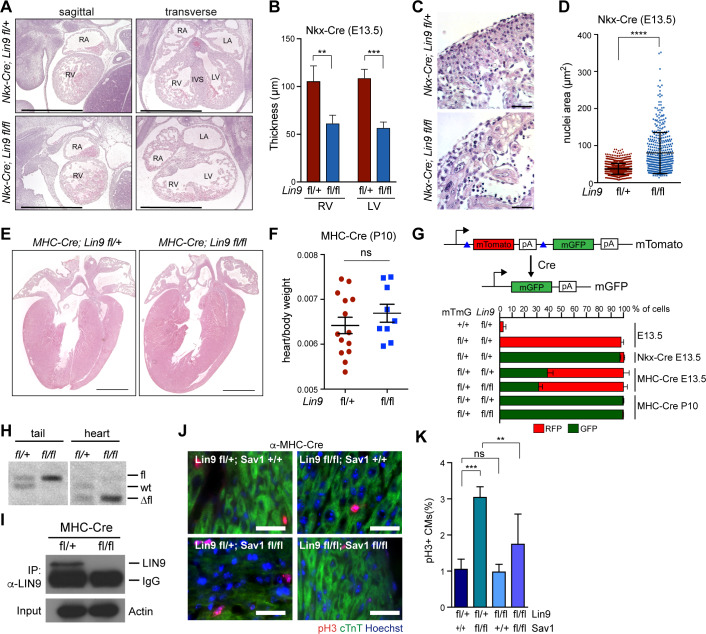
LIN9 is required for cardiomyocyte proliferation in Hippo-deficient postnatal hearts.A) H&E-stained sagittal and transverse sections of embryonic E13.5 hearts of mice with the indicated genotypes. RA: right atrium, RV: right ventricle, LA: left atrium, LV: left ventricle, IVS: interventricular septum. Scale bar: 1 mm B) Thickness of the right and left ventricular compact myocardium. n = 5 Lin9fl/+ hearts and n = 3 Lin9fl/fl hearts. C) High magnification of the myocardium of Lin9fl/fl embryonic hearts demonstrating pleomorphic and enlarged nuclei. Scale bar: 25μm D) Quantification of the nuclear area in the myocardium of Lin9fl/+ and Lin9fl/fl embryonic hearts. E) H&E-stained sections of hearts from α-MHC-Cre; Lin9fl/+ and α-MHC-Cre; Lin9fl/fl mice at P10. Scale bar: 1 mm F) heart to body weight of α-MHC-Cre; Lin9fl/+ and α-MHC-Cre; Lin9fl/fl mice at P10. n = 14 control mice and n = 9 Lin9fl/fl mice. G) Top: Scheme of the mT/mG reporter. Upon expression of Cre-recombinase, mTomato is deleted and mGFP is activated. Bottom: Quantification of mTomato (mT) and mEGFP (mG) positive cardiomyoyctes. n = 3 to 4 mice per genotype. Example FACS data are shown in S3D Fig. H) PCR genotyping using primers to detect the wt, fl and Δfl allele of Lin9 demonstrating efficient deletion of Lin9 in the hearts of 10 days old α-MHC-Cre; Lin9fl/fl mice. Genomic DNA extracted from tail biopsies was used as control. I) To confirm that the LIN9 protein is lost in α-MHC-Cre; Lin9fl/fl hearts, lysates from P10 hearts with the indicated genotypes were immunoprecipitated and immunoblotted with anti-LIN9 antibodies. Immunoblotting of lysates with an Actin antibody served as a control. IgG denotes the heavy chain of the immunoprecipitating primary antibody. J) and K) Fraction of pH3-positive cardiomyocytes in the hearts of 10 days old mice with the indicated genotypes. Cardiomyocytes were identified by staining for cTnT. Scale bar 25μm. Lin9fl/+; Sav1+/+ n = 3, Lin9fl/+; Sav1fl/fl n = 6, Lin9fl/fl;Sav1+/+ n = 3 and Lin9fl/fl;Sav1fl/fl n = 7. B),D), I): Error bars indicate SDs. Error bars indicate SEM. Student’s t-test. * = p<0.05, ** = p<0.01, *** = p<0.001, ns = not significant.